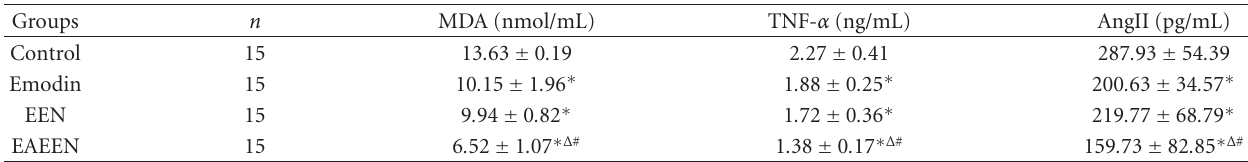
Table 1: Levels of MDA, TNF- α , and AngII in 4 groups (EEN: early enteral nutrition. EAEEN: emodin-assisted early enteral nutrition. MDA: maleic dialdehyde. TNF- α : tumor necrosis factor-alpha. AngII: angiotensinII).